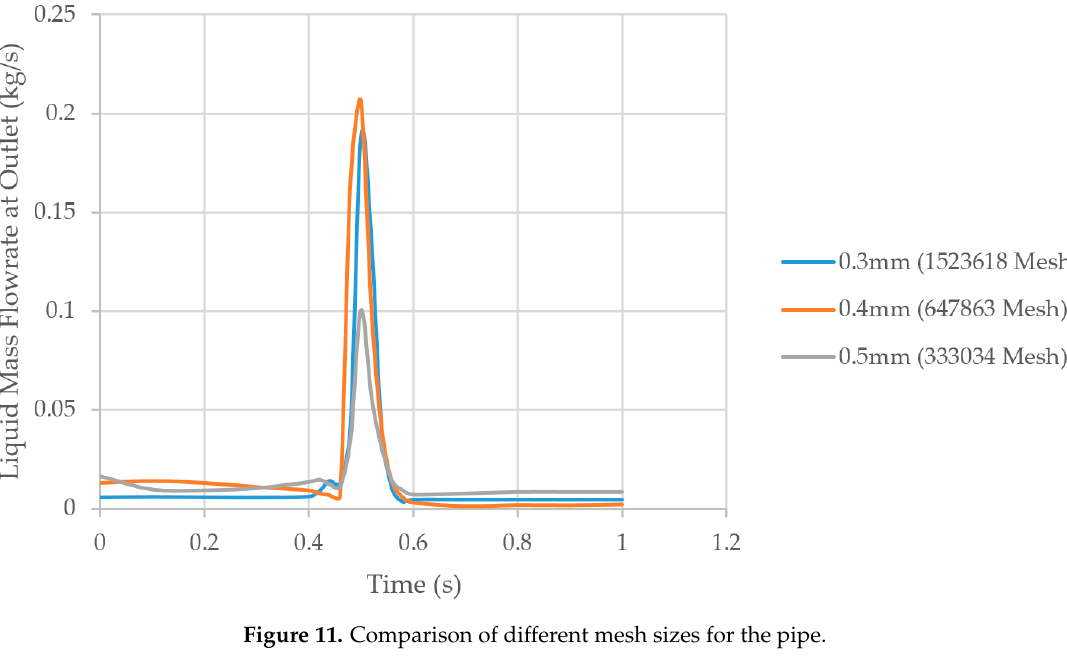
Figure 11. Comparison of different mesh sizes for the pipe.